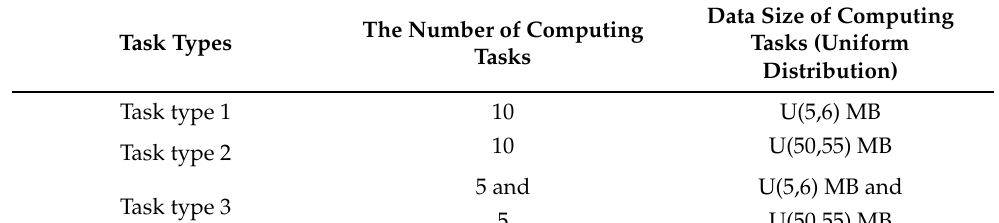
Table 2. Three different types of computing tasks.